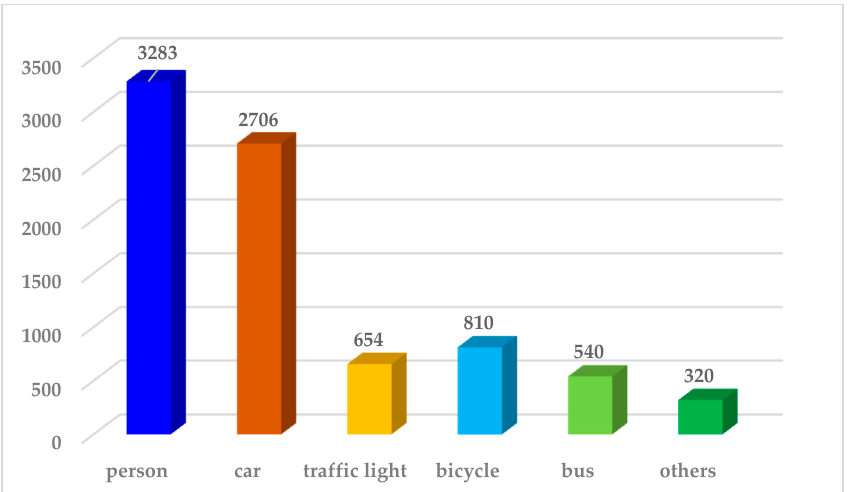
Figure 2. The label distributions in the proposed FTOD. Most of the annotated objects are cars (2706 labeled), pedestrians (3283 labeled), and bicycle (810 labeled).